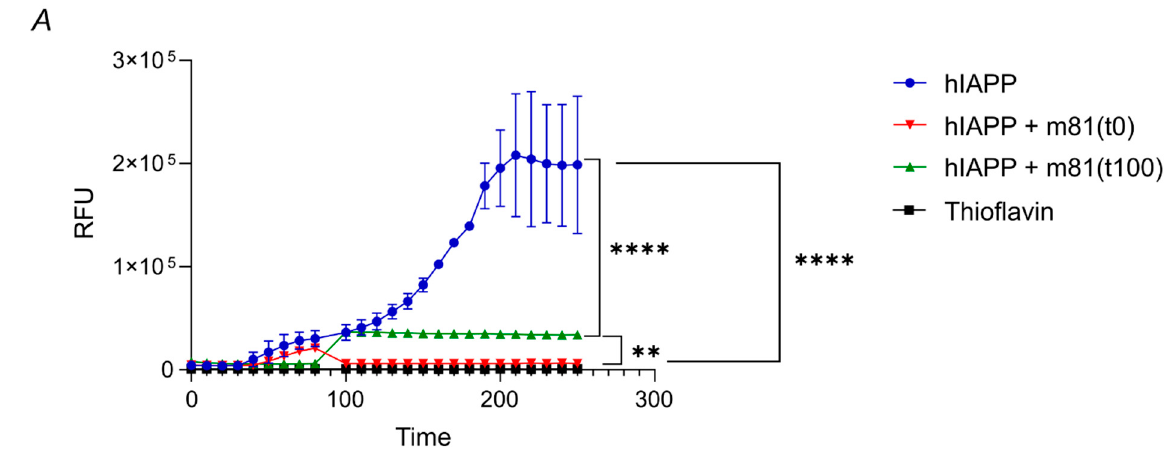
Figure 3. m81 mAb can prevent fibrils formation in vitro and block aggregation process up to an oligomeric stage. To investigate m81 mAb fibril blockage potential in vitro, synthetic human IAPP (hIAPP) was incubated at 37 °C, together with Thioflavin T, to detect the increase in fibril size. m81 mAb was either added at time point = 0 or 100 min. hIAPP, human IAPP; Thio, Thioflavin T. Data are presented as mean± SEM. ** p < 0.01, **** p < 0.0001.